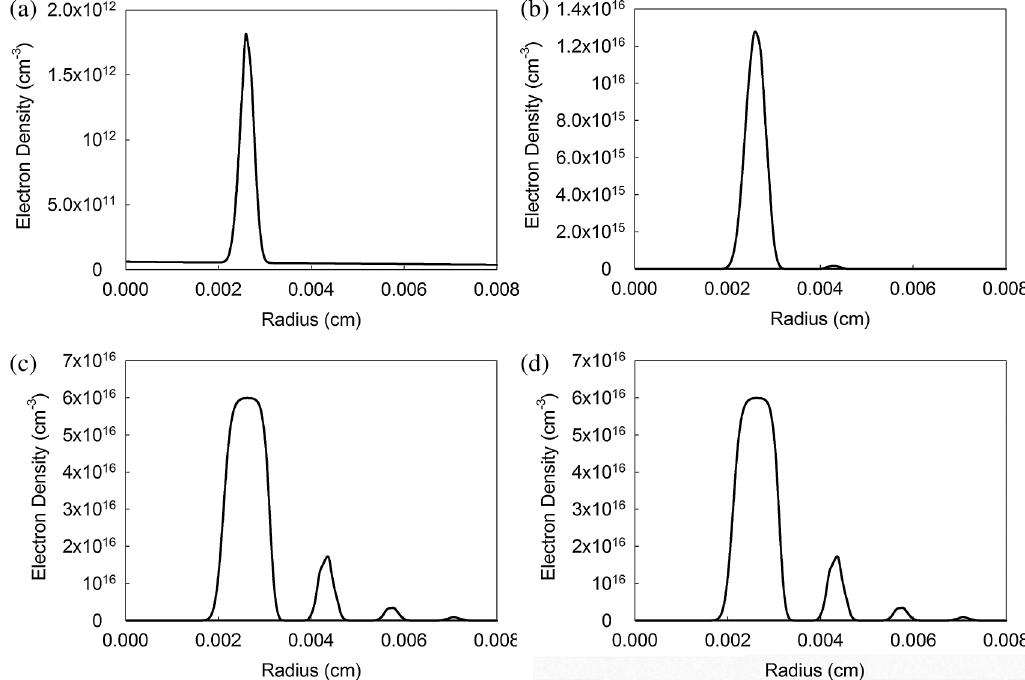
FIG. 5. Model predictions for radial electron density distribution for 45 mJ pulse energy at different times after the peak of the laser pulse (peak occurs at t ¼ 0 ). The input laser beam HWHM ¼ 0 : 7 cm . (a) At 21 fs. (b) At 42 fs. (c) At 63 fs. (d) At 0.27